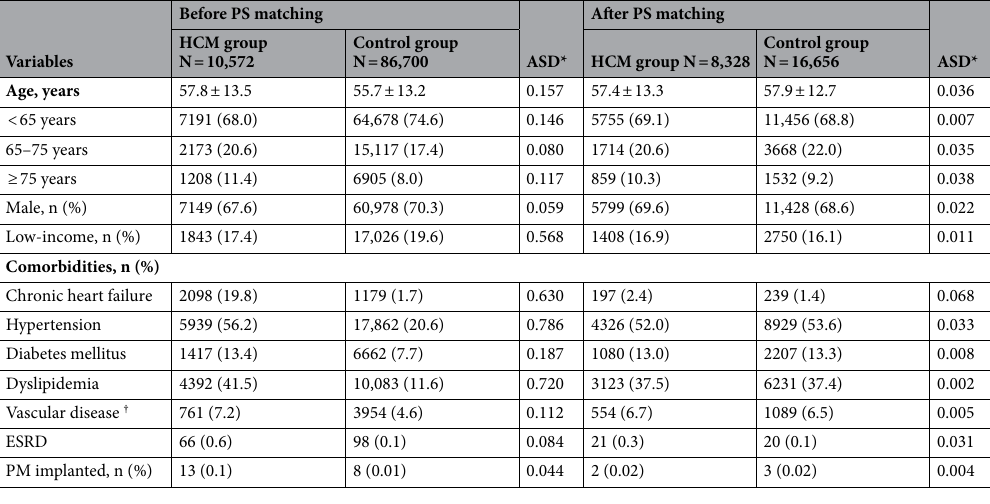
Table 1. Baseline characteristics of the study population. ASD absolute standardized difference, ESRD end- stage renal disease, HCM hypertrophic cardiomyopathy, PM pacemaker, PS propensity score. *ASD of < 0.1 indicated a negligible difference between the two groups. † Vascular disease included myocardial infarction and peripheral artery